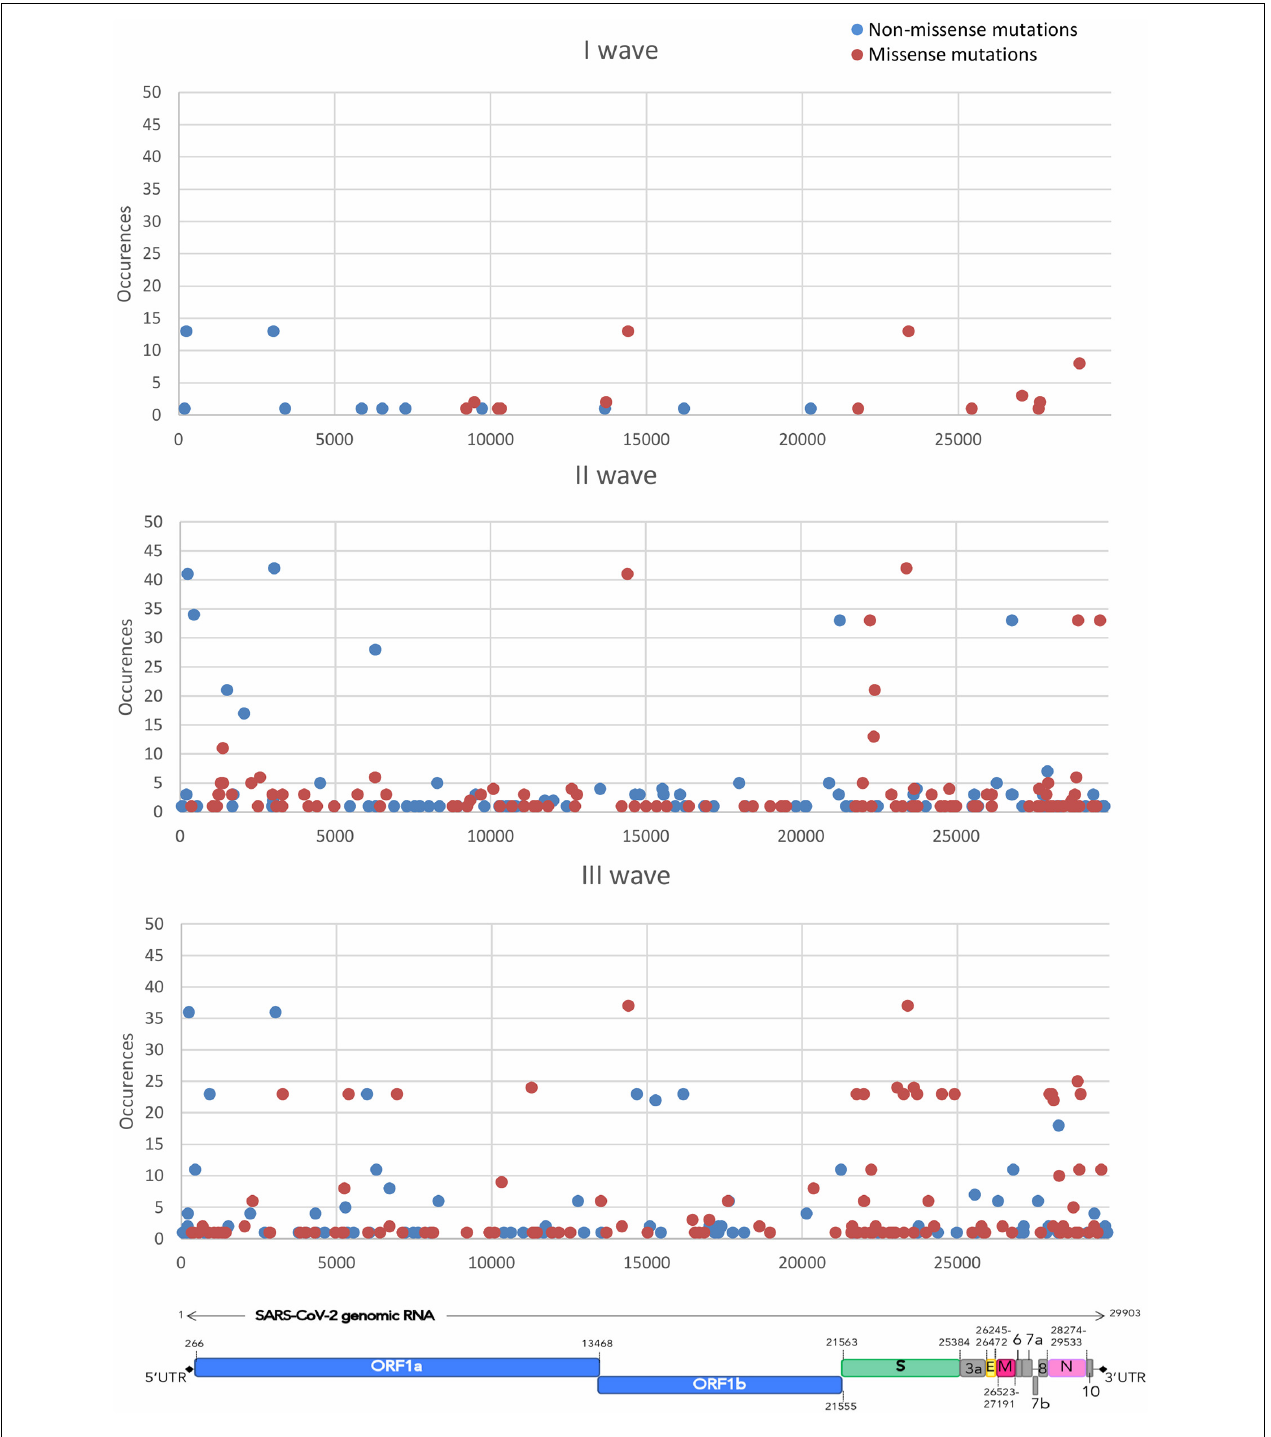
FIGURE 2 | The figure shows the distribution of the accumulation of the different mutations throughout the SARS-CoV-2 genome over time. Missense mutations are shown in red and non-missense mutations, including synonymous, upstream and downstream variants, are shown in blue.